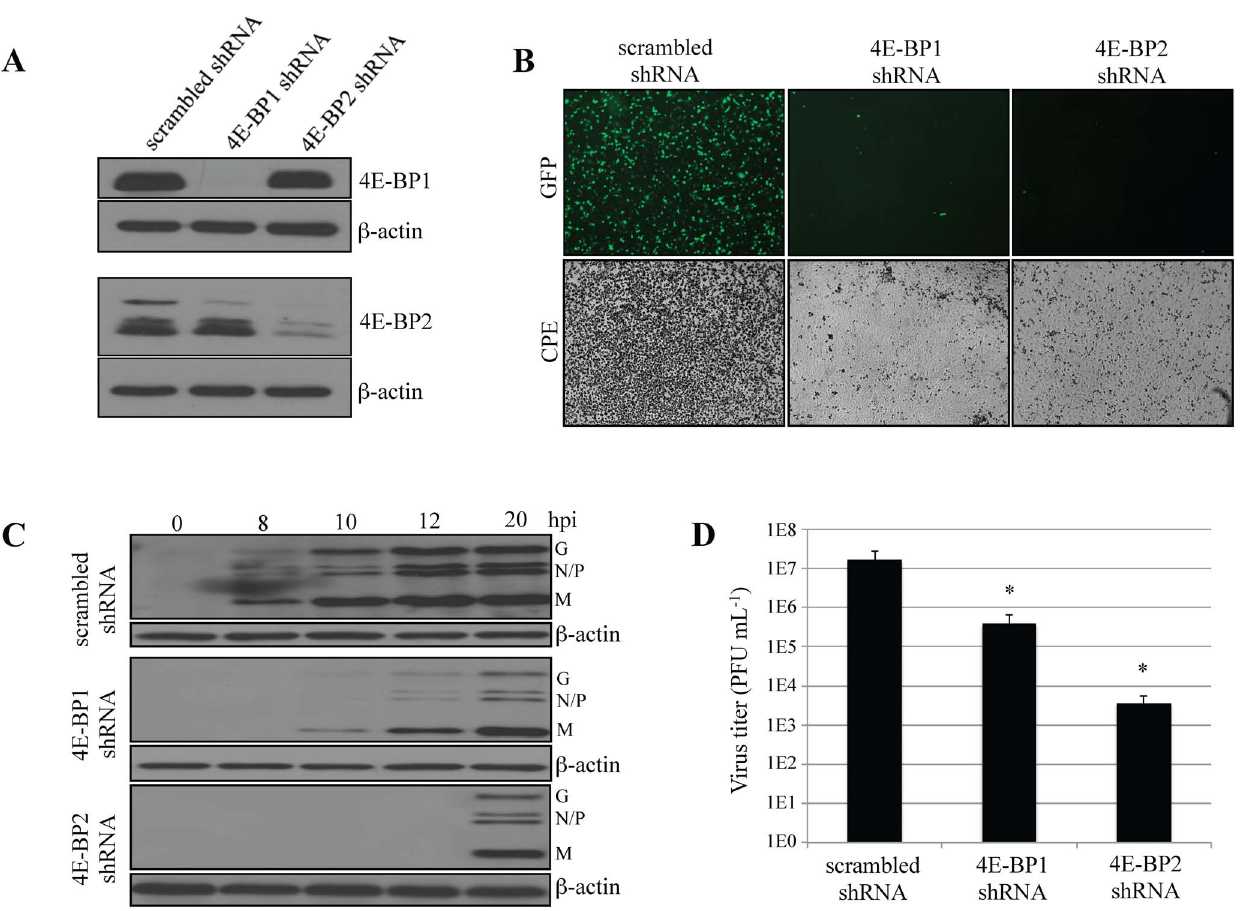
Fig. 1. Silencing 4E-BP1 or 4E-BP2 inhibits VSV replication in MEFs. (A) Western blotting analysis of 4E-BP1 or 4E-BP2 expression following transduction of WT MEFs with lentiviruses containing a non-specific shRNA (scrambled), or a shRNA targeting 4E-BP1 or 4E-BP2 mRNA. b -actin served as a loading control. (B) Scrambled MEFs and MEFs knockdown on 4E-BP1 or 4E-BP2 were infected with VSV-GFP at a MOI of 1 PFU/cell and virus replication was assessed by GFP fluorescence and cytopathic effect (CPE). (C) Western blotting analysis for the detection of VSV proteins at the defined time points post-infection with VSV-GFP at a MOI of 1 PFU/cell. b -actin was used as a loading control. (D) Viral titer quantified by plaque assay at 24 hpi with VSV-GFP at a MOI of 1